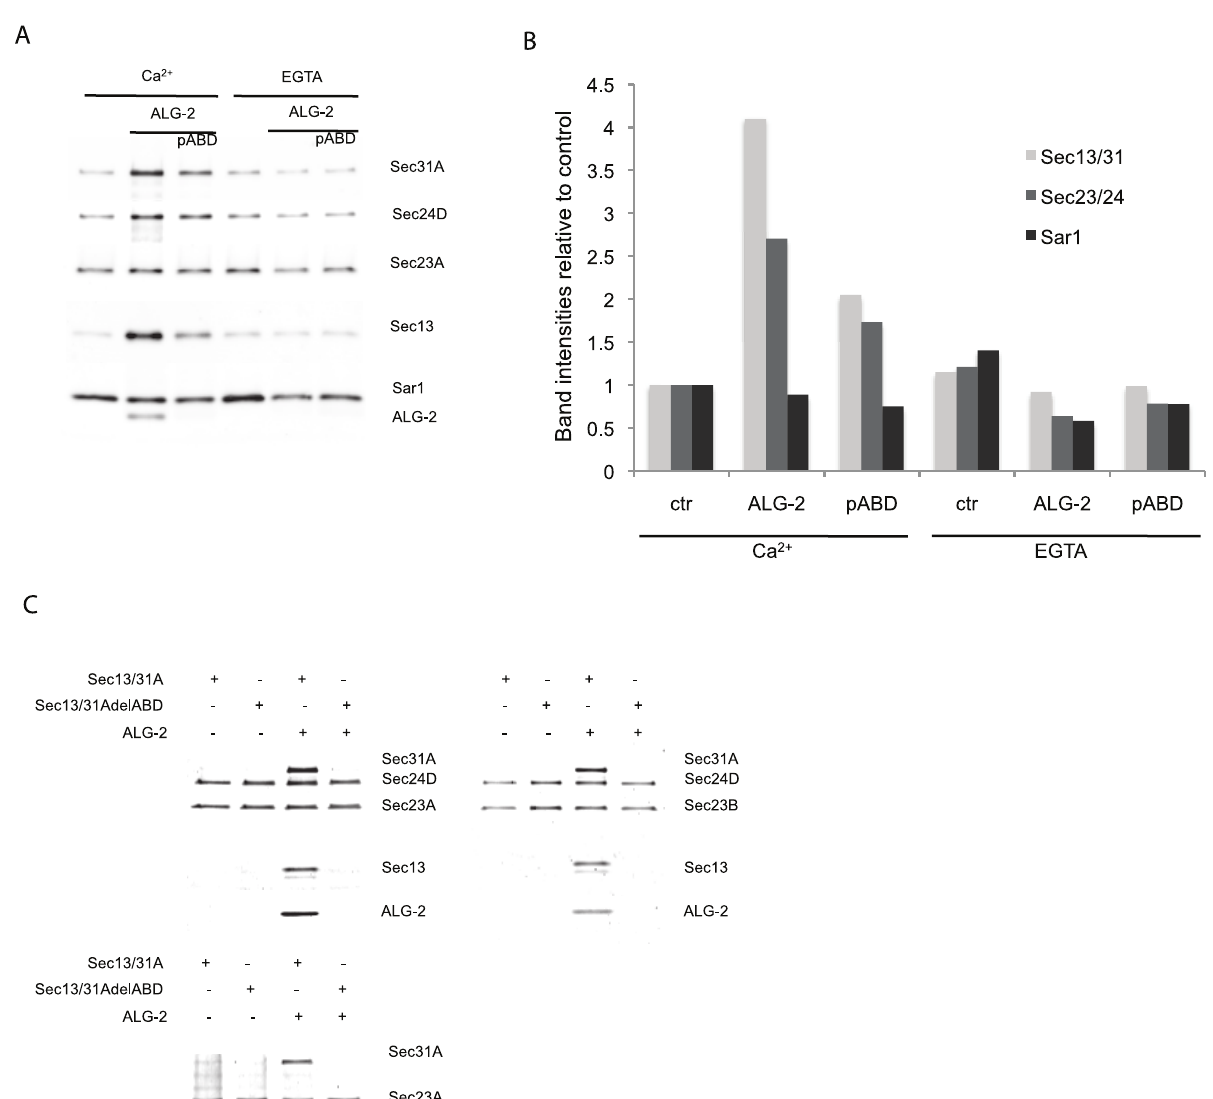
Figure 4. Sec31A is recruited to liposomes and Sec23 in an ALG-2-dependent manner. A. Recombinant proteins bound to artificial liposomes and collected from a sucrose gradient were analyzed for recruitment efficiency in the presence of ALG-2 and a peptide representing the ABD (pABD). Antibodies directed against Sec31A, HA tag (HA-Sec13), Flag-tag (flag-Sec23A), Sar1 and ALG-2 were used to analyze protein recruitment. The immunoblot is representative of more than three independent experiments. B. Quantification of band intensities relative to Ca 2 + control (ctr) in representative immunoblot. C. Anti-Flag antibody coated beads were used as bait for flag-Sec23. Protein binding was performed in the presence of Ca 2 + and proteins in gels were visualized using SyproRed